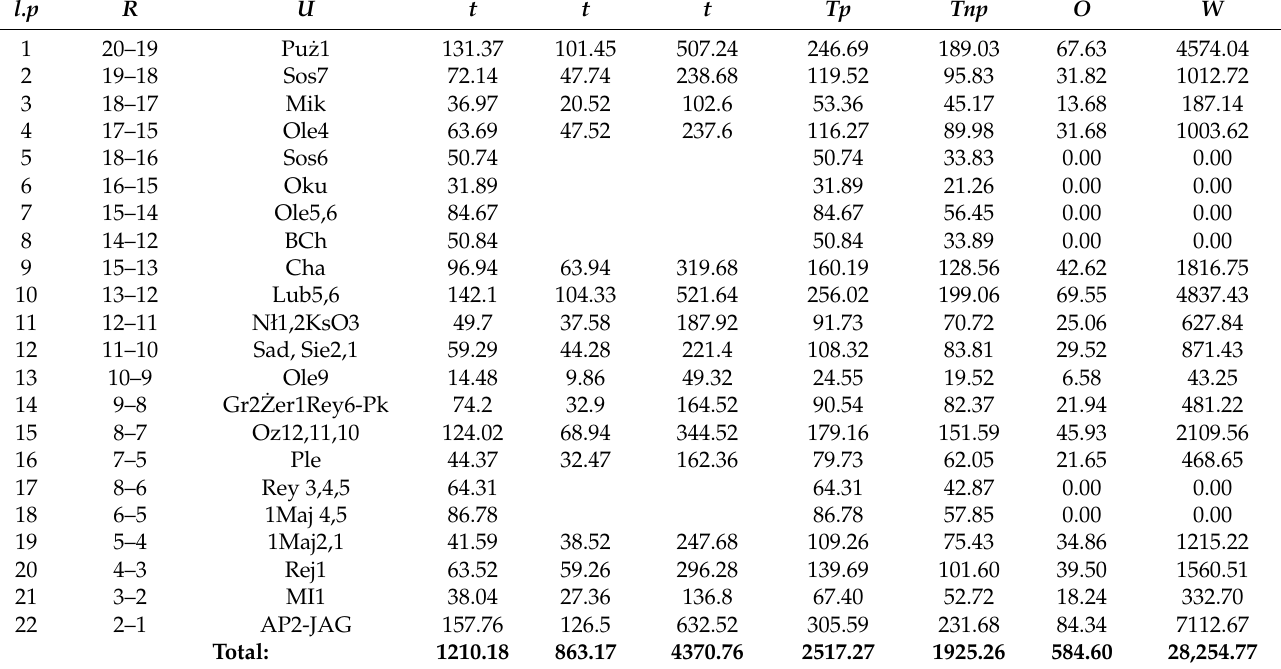
Table 5. Computation of variance and standard deviation for the current bus line no. 3.